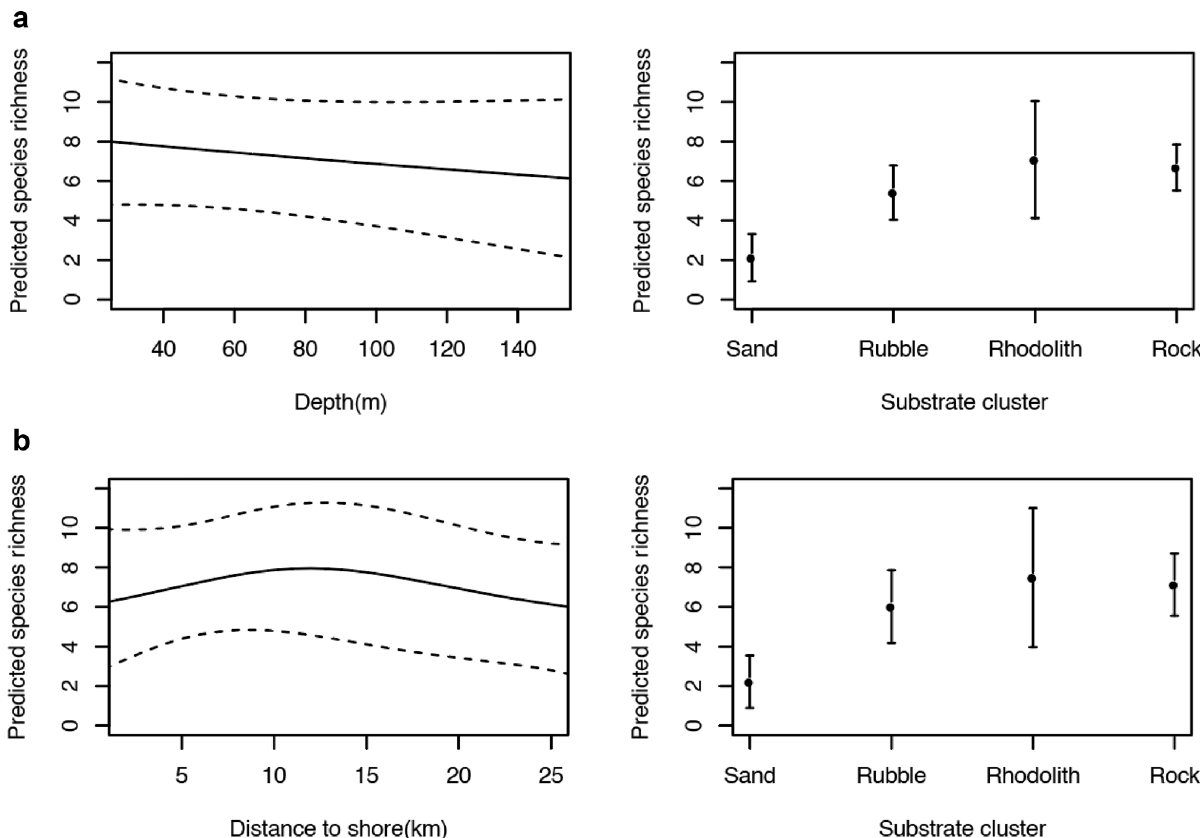
Figure 5. Generalized Additive Models (GAMs) for species richness in relation to (a) depth and (b) distance to shore and substrate cluster, which was the benthic explanatory variable with the lowest p-value. In the line graphs, the solid lines represent the predicted abundance or probability of presence per grid cell, and the dashed lines illustrate 95% confidence intervals. In the habitat category plots, dots represent the predicted probability of presence and whiskers illustrate 95% confidence intervals. Graphs created in R statistical software 59 (CRAN ver.